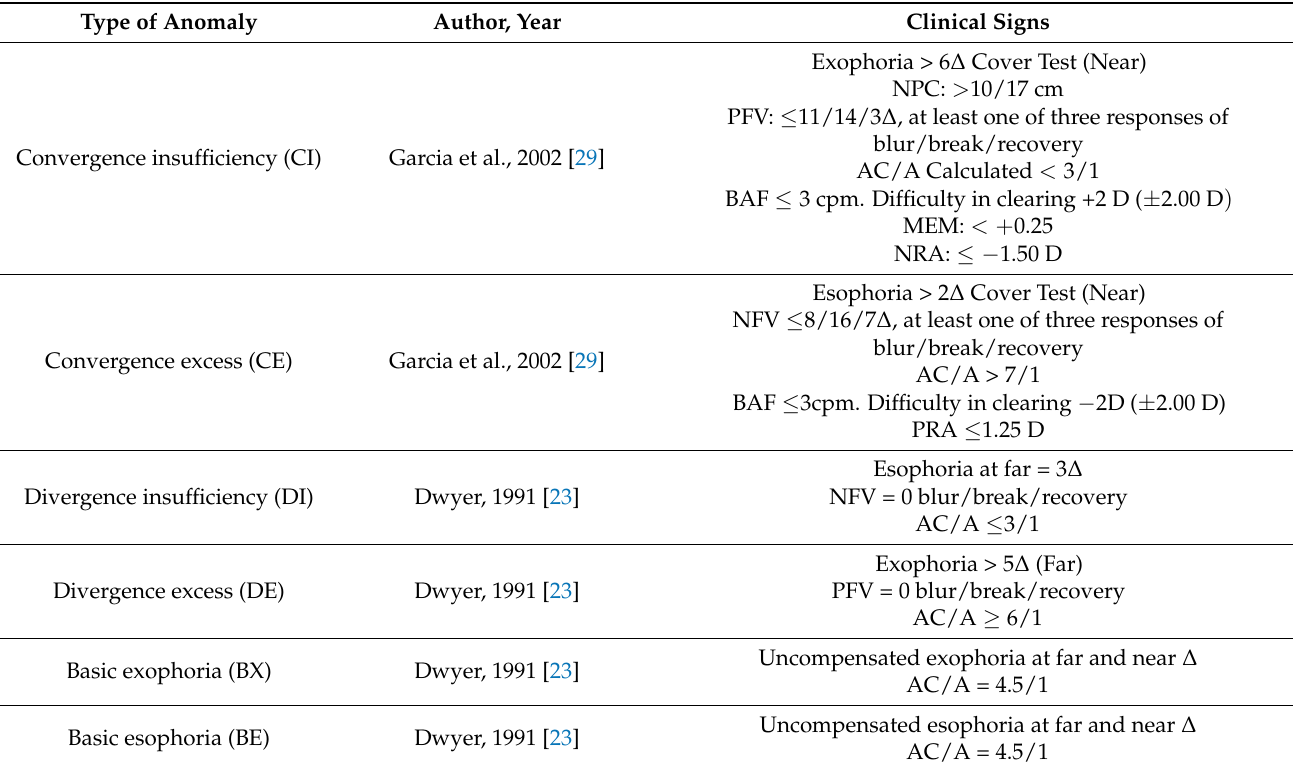
Table 1. Diagnostic criteria defined in the peer-reviewed literature for non-strabismic binocular anomalies that have been used in the current study.